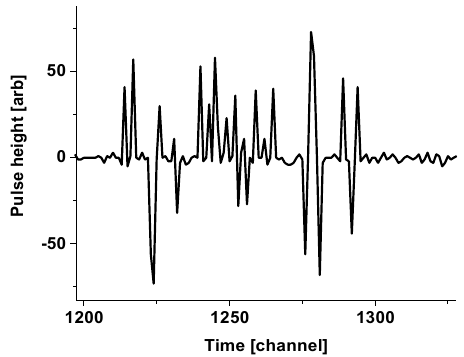
Fig. 4. :The enlarged area from the Fig. 3 to make individual pulses visible burst and the FWHM=23.9 and a small group with n l =131.7 and FWHM=21.3. Two group caused by the effect of the threshold in peak search algorithm implemented for FC pulse counting. The neutrons were calculated according to number of peaks above the threshold using constant fraction time marking algorithm, described in our previous publications